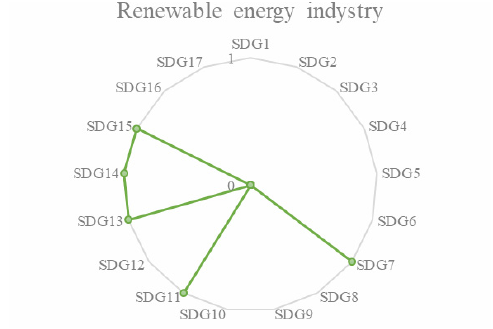
Figure 10. Renewable energy industry cluster of application effect on the